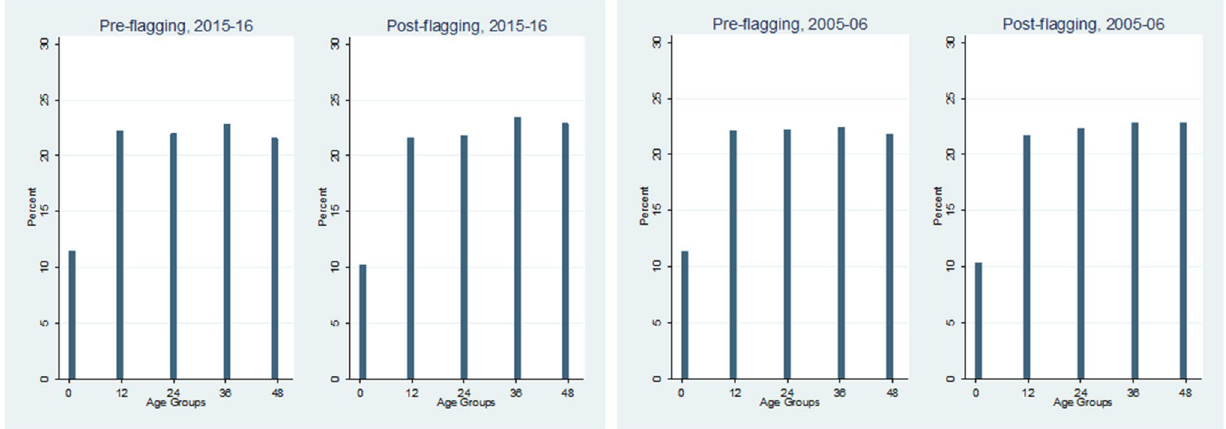
Figure 5. Pre- and post-flagging age distribution in groups of 12 months.